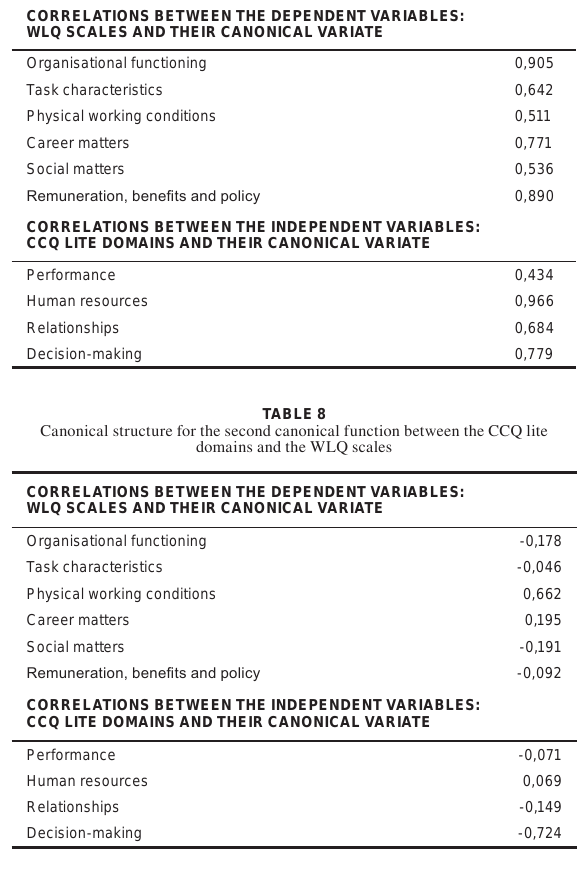
Table 7 Canonical structure for the first canonical function between the CCQ lite domains and the WLQ scales